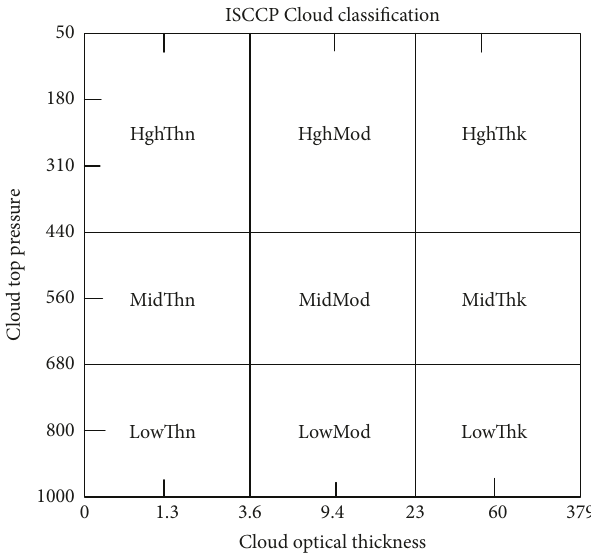
Figure 1: Cloud-type definitions used in this paper for daytime.